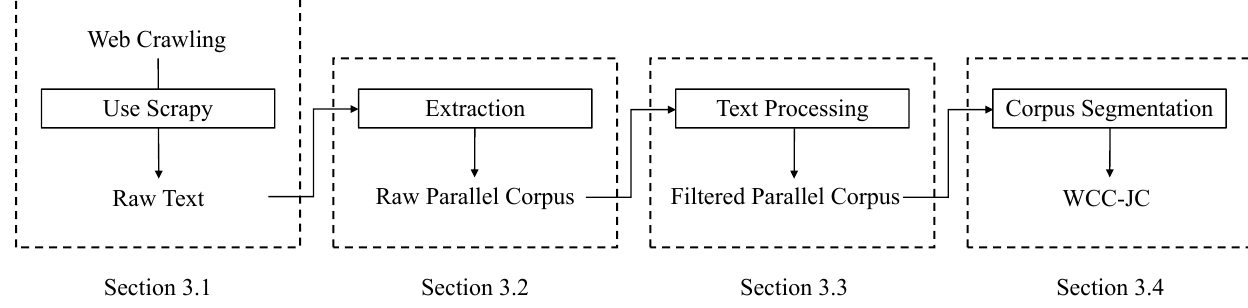
Figure 2. Workflow for the creation of the corpus from raw subtitle files.